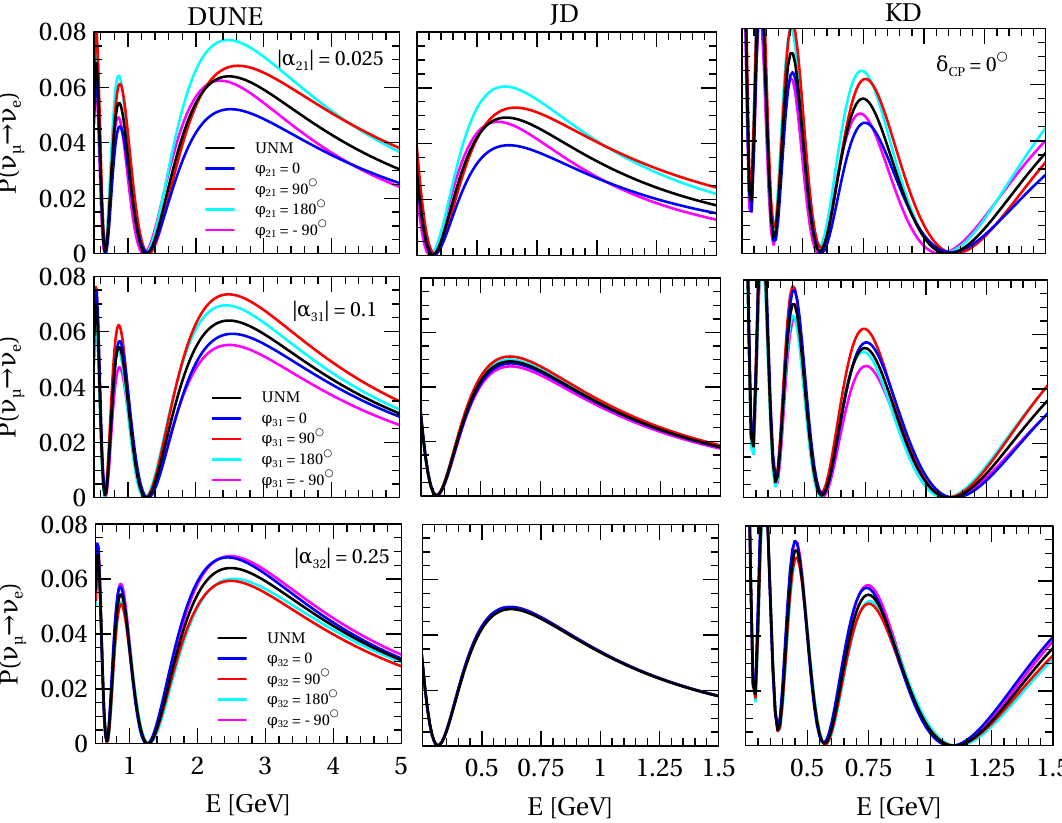
Figure 1 . ν µ → ν e appearance probability as a function of energy in the presence of off-diagonal NUNM parameters. Left, middle, and right columns correspond to the baselines of 1300 km (DUNE), 295 km (JD), and 1100 km (KD), respectively. The four colored curves correspond to four benchmark values of the phases associated with off-diagonal NUNM parameters: 0 ◦ , 90 ◦ , 180 ◦ , and − 90 ◦ . We consider δ = 0 ◦ and sin 2 θ = 0 . 5 . The values of the other oscillation parameters CP 23 are taken from table